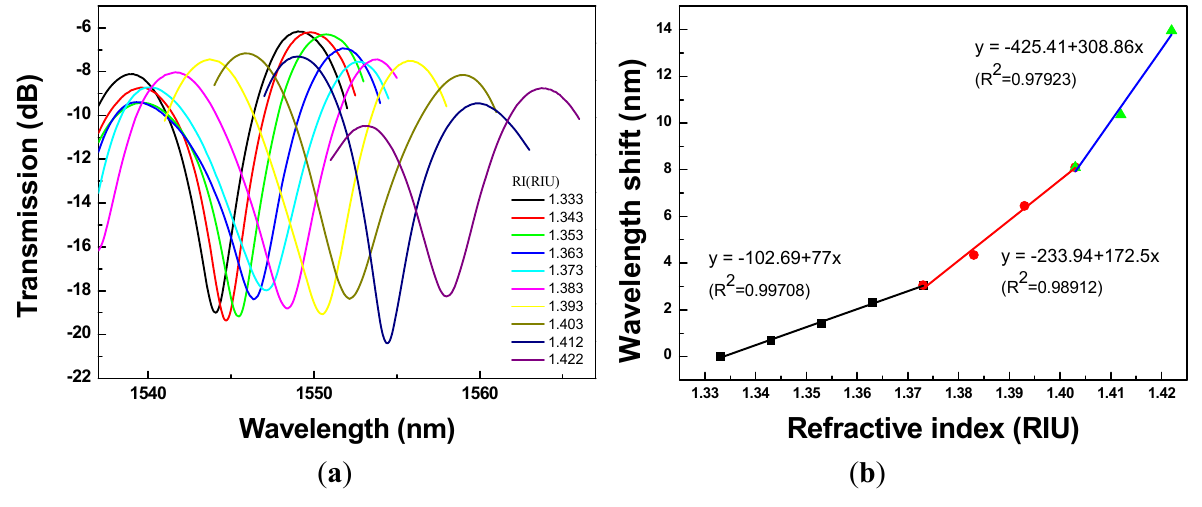
Figure 12. A 5.00-cm PCF interferometer with: ( a ) the transmission spectra for sensing different refractive indices of the sucrose solution (RI =1 .333 − 1.422); ( b ) the relationship between wavelength shift versus refractive index (resonance wavelength = 1,544.05